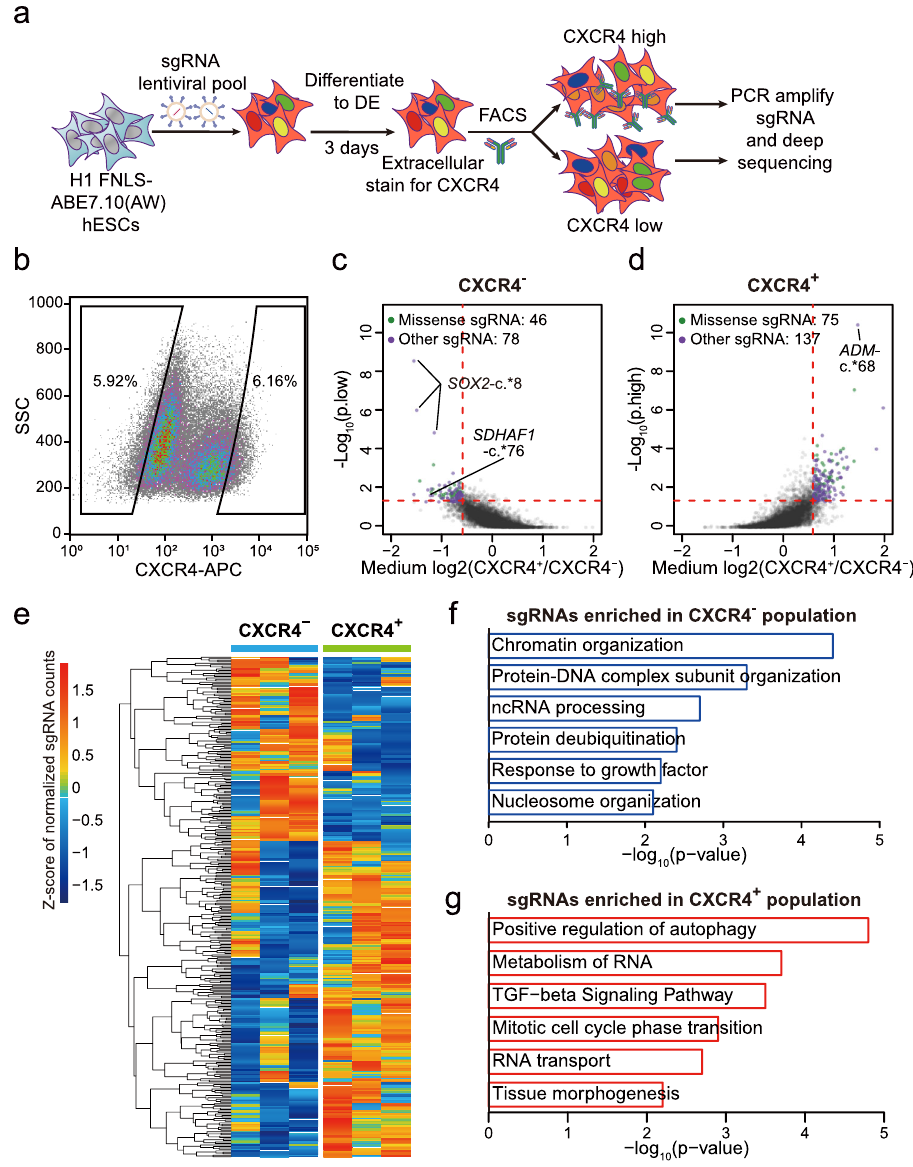
Fig. 3 FNLS-ABE7.10(AW) base editor-based functional screening of m 6 A sites in H1 hESCs. a Flow chart of ABE-based screening of m 6 A sites is important for endoderm speci fi cation. b Representative CXCR4 FACS gating strategy for sorting CXCR4 − and CXCR4 + populations, respectively. SSC side scatter. c , d Scatter plot showing the strategy to determine the sgRNAs signi fi cantly enriched in CXCR4 − ( c ) and CXCR4 + ( d ) populations, respectively. e Heatmap showing the normalized counts of sgRNAs enriched in CXCR4 − or CXCR4 + populations for each replicate. f , g GO-enrichment analyses of the genes targeted by the sgRNAs signi fi cantly enriched in the CXCR4 − ( f ) or CXCR4 + ( g ) populations, (Supplementary Fig. 8a), and uniform expression of key pluripotent marker NANOG, OCT4, and SOX2 (>99%) (Supple- mentary Fig. 8b), as well as the proliferation marker Ki67